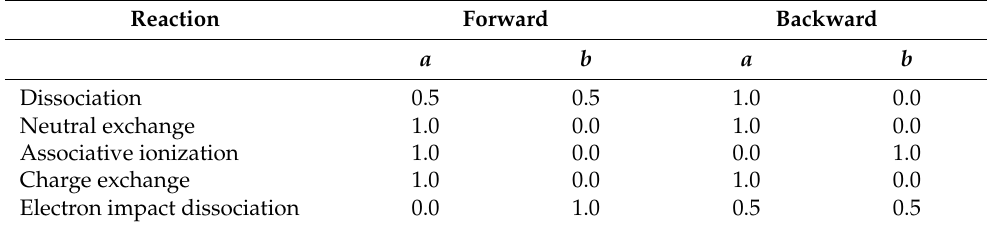
Table 2. Weight factors of the controlling